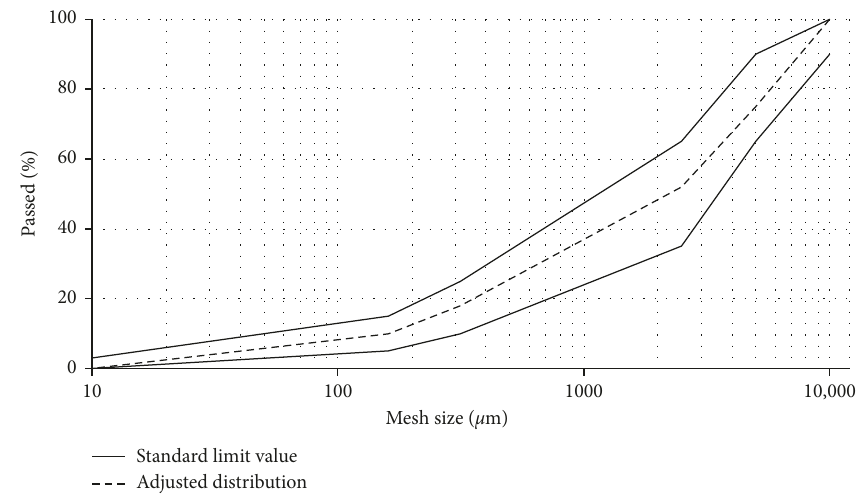
Figure 2: Grain-size curve of the pumice